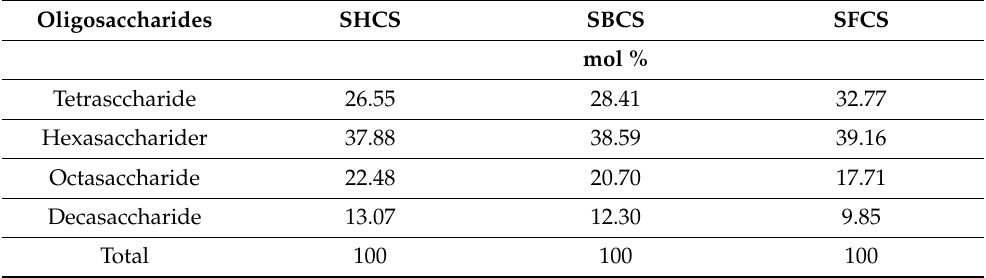
Table 4. The Ratio of Oligosaccharides in the Hyaluronidase Digests of CS Preparations from Chinese Sturgeon Cartilage.